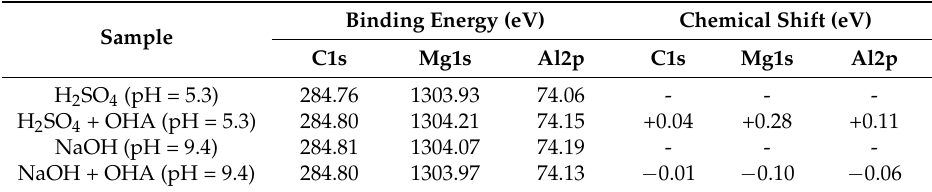
Table 6. Binding energies of elements on MA-spinel surface.